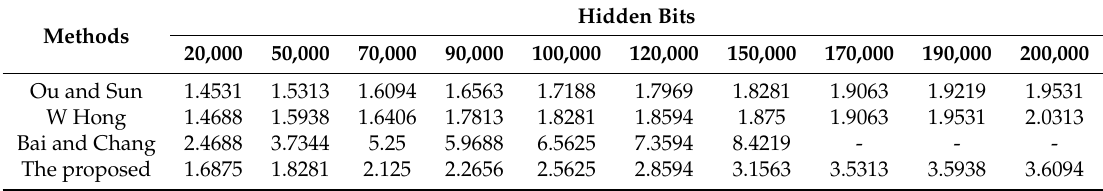
Table 4. Comparing the CPU time between the proposed and the existing methods (measurement: seconds). Methods Ou and